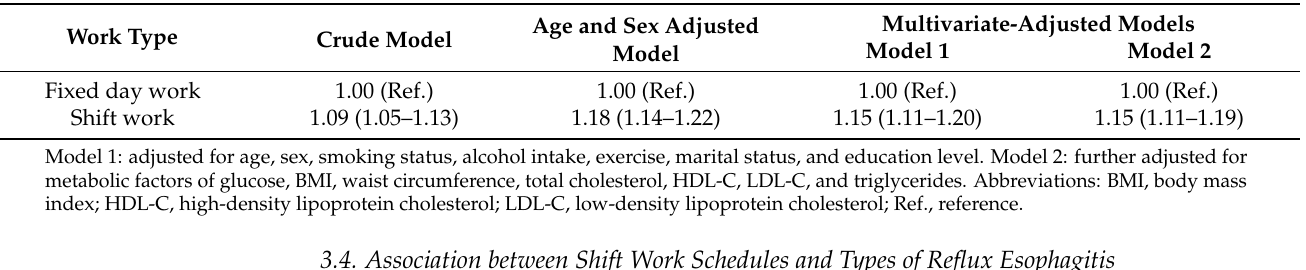
Table 3. Association between shift work and reflux esophagitis.